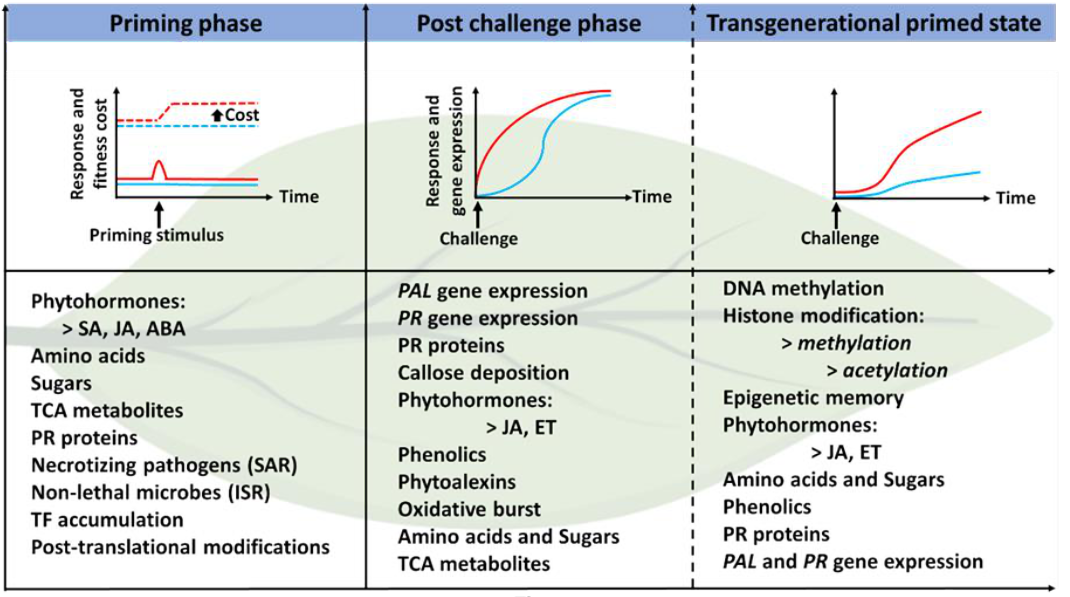
Figure 7. Summarised illustration of varying phases in plant priming and the induction of transgenerational memory. The scheme shows differences in plant response (solid lines) and fitness cost (dashed lines) between plants (red) and non-primed plants (blue). The perception of a priming stimulus by a plant triggers a transient defence response resulting the alteration of various primary and secondary metabolites such as amino acids, sugars, phytohormones, phenolics and proteins which comes at an initial high fitness cost as compared a non-triggered plant at the onset of priming and further maintenance of a primed state. Upon challenge by a stressor, primed plants experience low fitness cost as compared to the direct activation of defence by non-primed, which allows for an earlier, faster and more robust defence response (post-challenge phase). A transgenerational primed state is achieved when progeny plants of previously primed parents inherit epigenetic modifications regulating the state of defence priming, progeny plants are thus able to respond more robustly to a stress